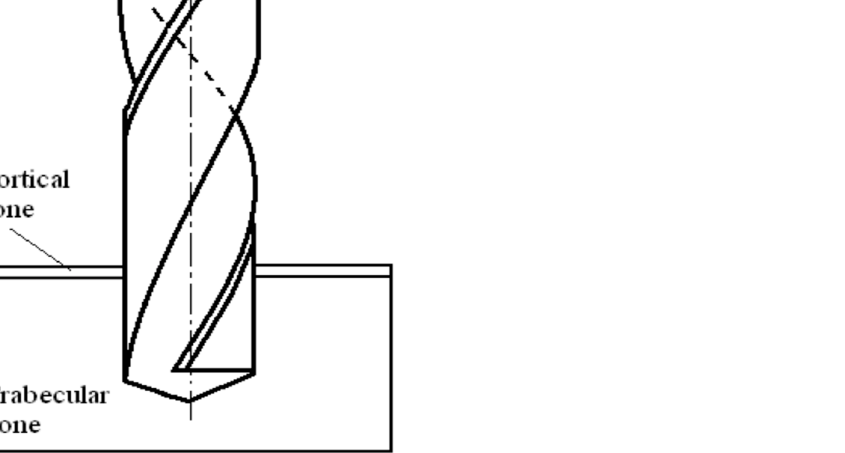
Figure 7. Schematic showing drilling into cortical and trabecular bone [21].